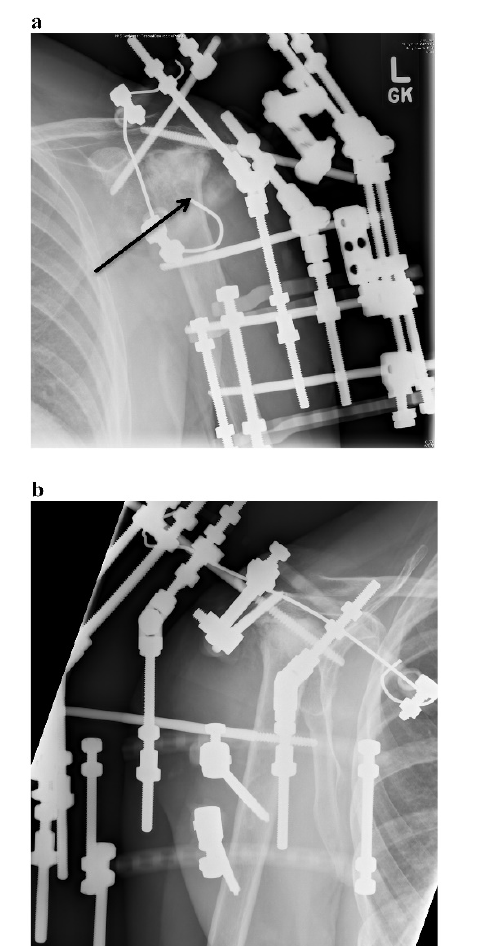
Figure 4 . (a and b). Immediate AP and Lateral postoperative radiograph showing the construct of the Ilizarov fixator. The anterior bone defect was filled with absorbable antibiotic carrier (black